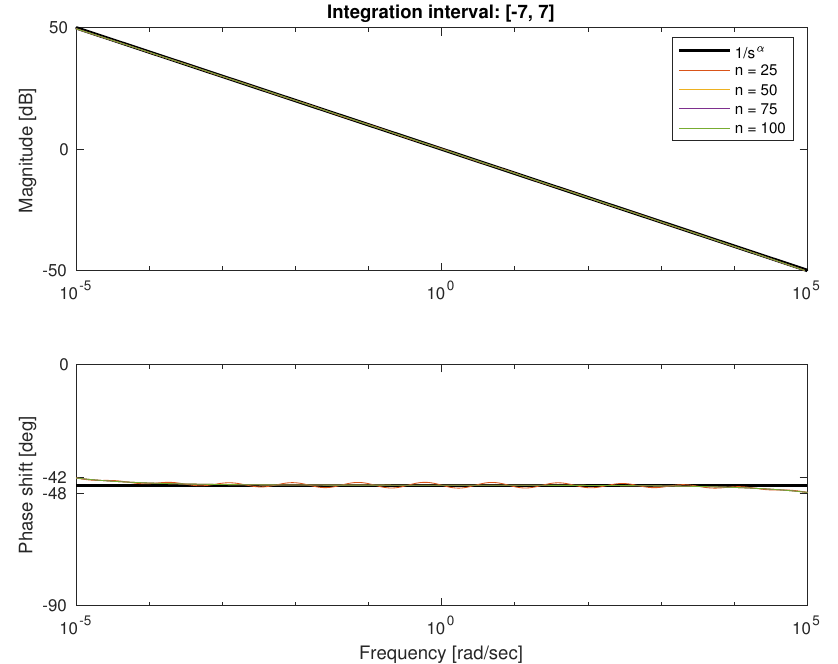
Figure 11. Analysis of frequency responses approximations with Clenshaw–Curtis quadrature and the integration interval of [ − 7,7 ]